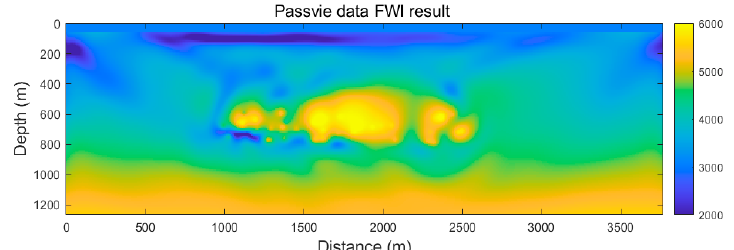
Figure 9. The conventional FWI result of the passive source data with noise.